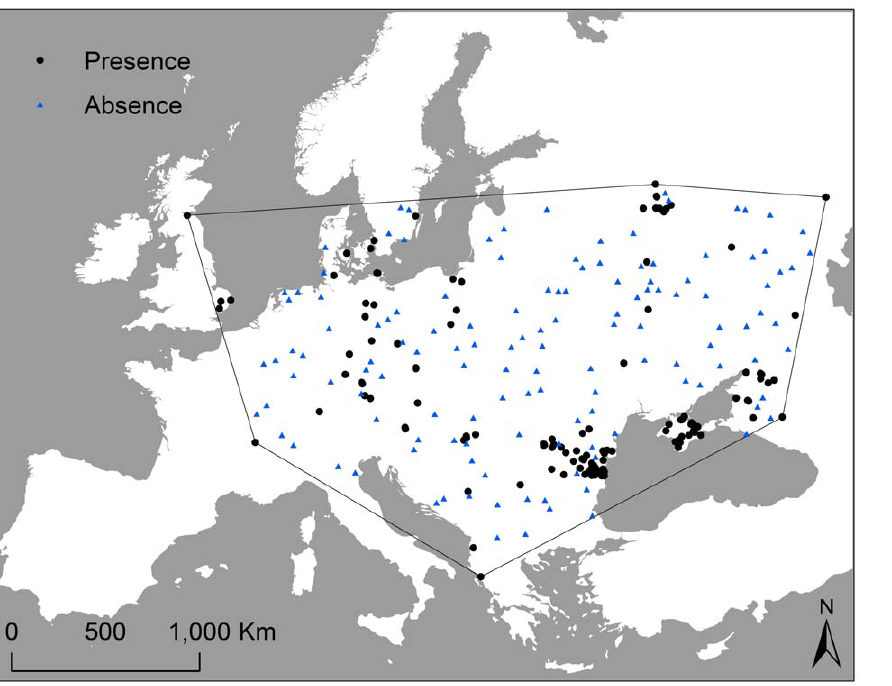
Figure 2. Distribution of presence and absence of highly pathogenic avian influenza (HPAI) H5N1 occurrences in poultry in Europe from 2005 to 2008. The polygon indicates the minimum convex polygon of poultry infections. Black dots indicate presence and blue triangles indicate absence (one training subset).